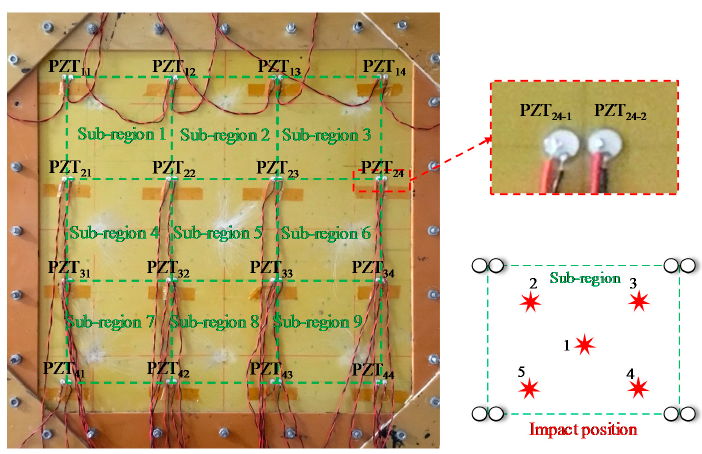
Figure 17. The glass fiber laminate plate and PZT sensors on it.